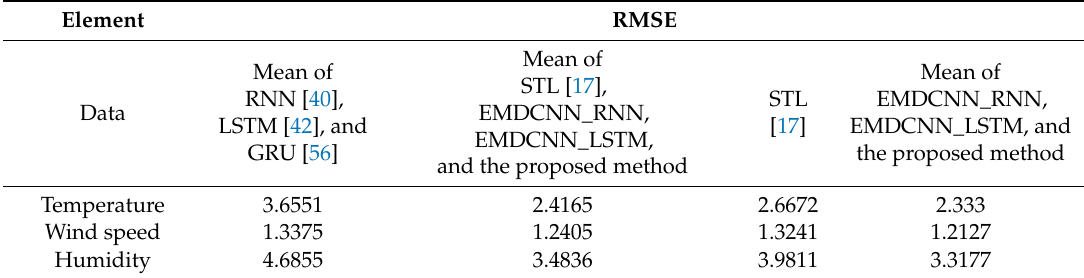
Table 2. Comparisons of the means of RMSE.